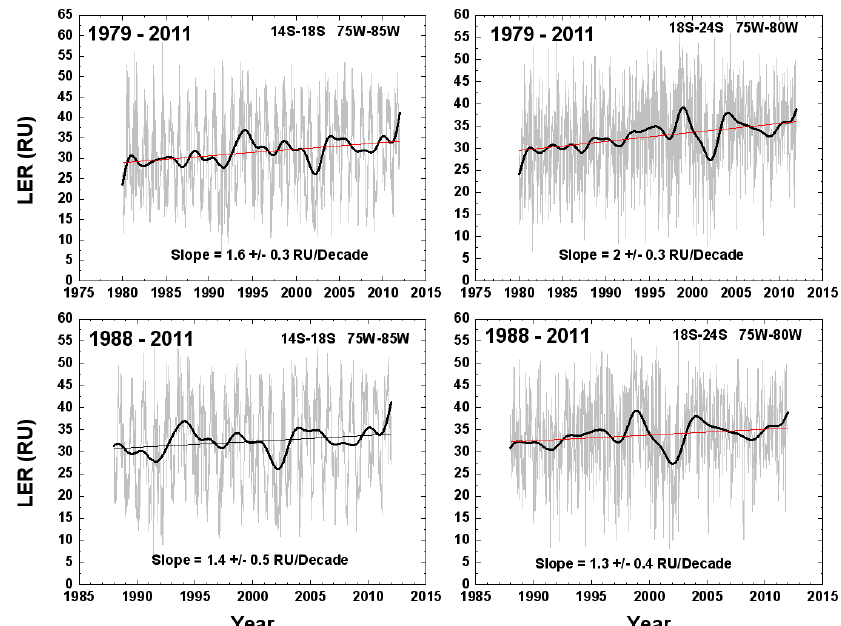
Fig. 17. Comparison of change in LER associated with Peruvian maritime stratus for the period including N7-SBUV (1979 to 2011) and without N7-SBUV (1988–2011) for two Pacific Ocean locations west of Peru (14 ◦ S–18 ◦ S, 75 ◦ W–85 ◦ W; and 18 ◦ S–24 ◦ S, 75 ◦ W–80 ◦ W).